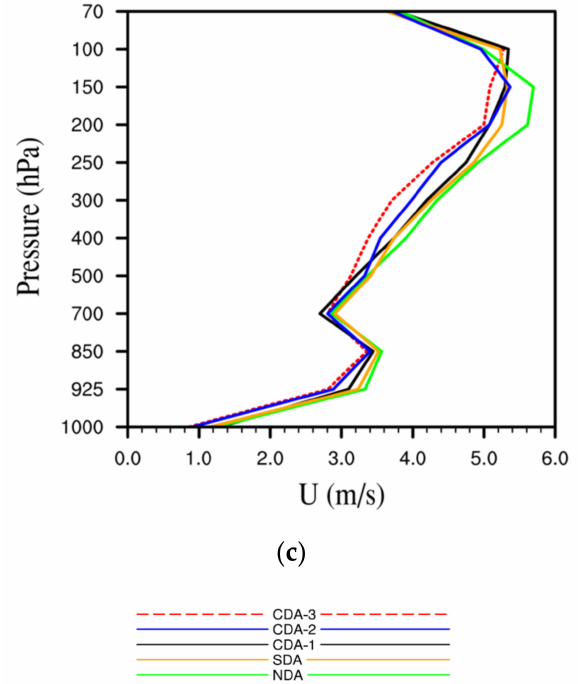
Figure 10. RMSE vertical profiles of 24 h forecast verified against ERA-5 data for five experiments: ( a ) water vapor mixed ratio (g/Kg); ( b ) temperature (K); ( c ) zonal wind (m/s).